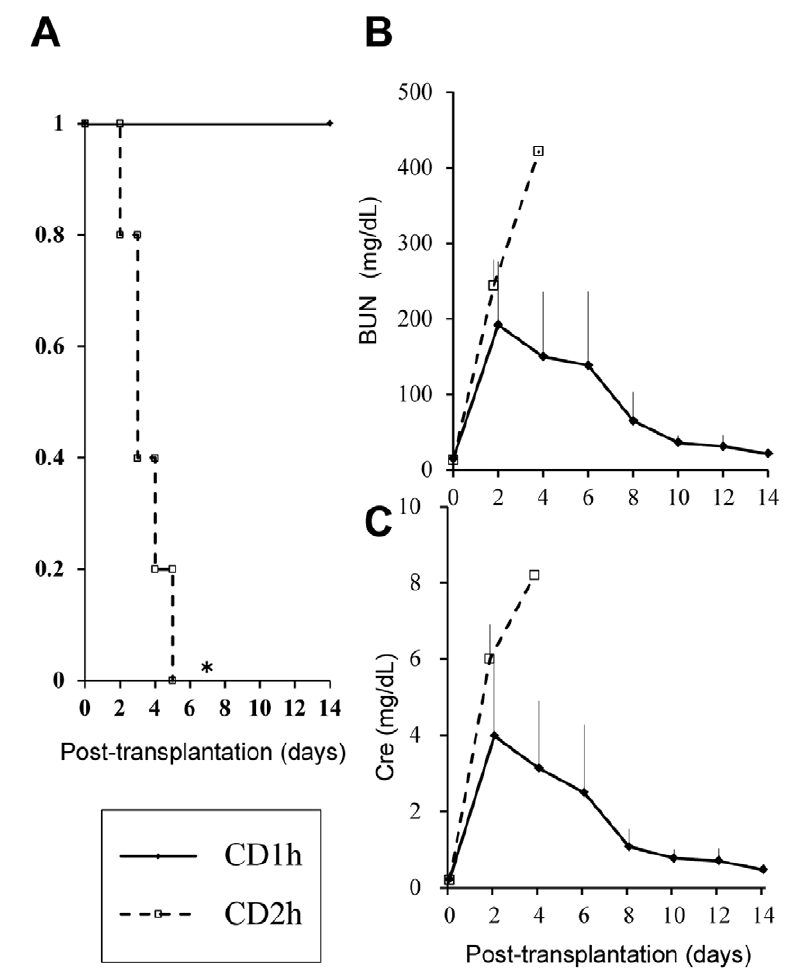
Figure 1. Survival rate, blood urea nitrogen (BUN) and serum creatinine (Cre) levels in experiment 1. (A): Survival rate of each group. Survival rate of the CD1h group was significantly greater than that of the 2-h post-CD group (* p , 0.01 using Log-Rank test.). (B): BUN. (C): Cre. BUN and Cre levels of all surviving rats were gradually recovered to a normal range by day 14 after RTx.